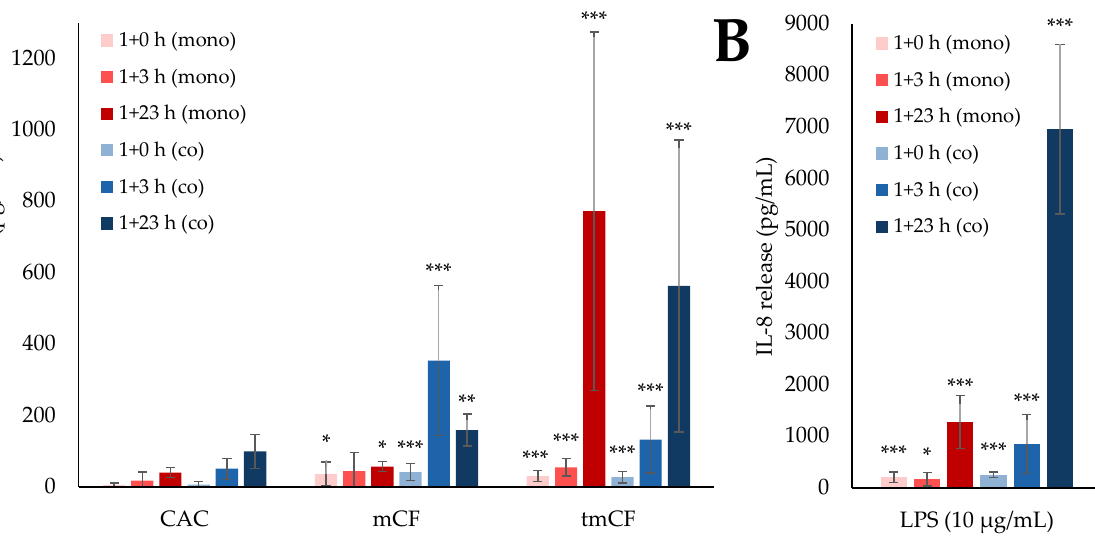
Figure 6. Interleukin-8 (IL-8) release from BEAS-2B mono-cultures (mono, red bars) as well as BEAS-2B/dTHP-1 co-cultures (co, blue bars) after exposure to mechanically (mCF) and thermo-mechanically treated carbon fibers (tmCF) ( A ) and 10 µg/mL lipopolysaccharide (LPS) ( B ). BEAS-2B cells were seeded as mono-cultures at a density of 2 × 10 5 /cm 2 . For co-culture treatment, dTHP-1 cells were seeded on top with a density of 3.95 × 10 4 /cm 2 after 4 h. The next day, mono- and co-cultures were exposed to CF samples with average surface doses of 7.00 ± 1.25 µg/cm 2 (mCF) or 6.55 ± 1.96 µg/cm 2 (tmCF) and post-incubated for 0, 3, or 23 h. Clean air controls (CAC) and LPS exposed cultures received equivalent treatment. The supernatants were analyzed for IL-8 release. The mean values ± SD of three independent experiments performed in duplicates are displayed. Statistical analysis was performed to assess differences between untreated and treated cells using Student’s t -